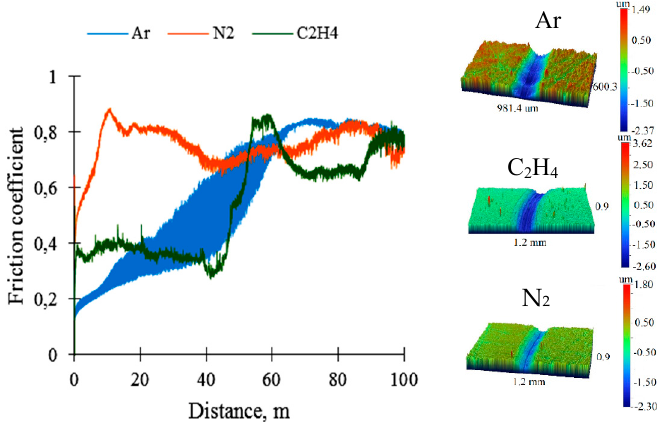
Figure 6. Dependence of the friction coefficient on the distance and 3D profiles of the tribo-contact zones (Al 2 O 3 counter-body).